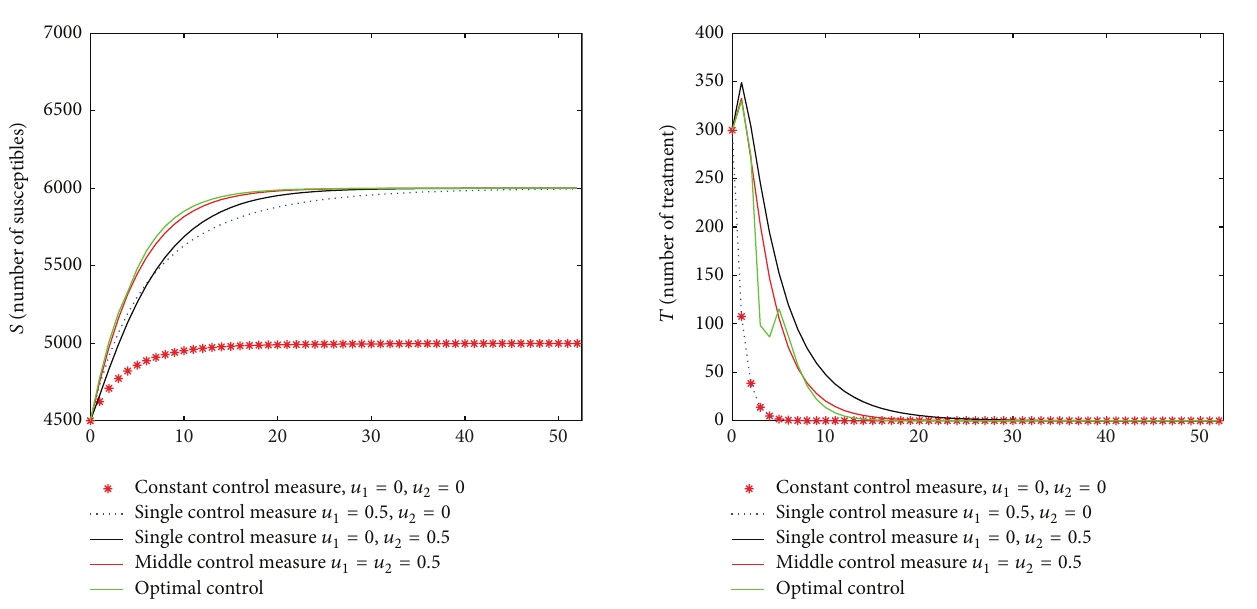
Figure5:Numberofthesusceptibleswhenwechoosetheweightsin objective function are 𝑐 1 = 10 2 ;𝑐 2 = 10 4 and under different optimal control strategies, that is, (1) without control: 𝑢 1 = 𝑢 2 = 0 ; (2) single control: 𝑢 1 = 0.5 , 𝑢 2 = 0 ; (3) single control: 𝑢 1 = 0 , 𝑢 2 = 0.5 ; (4) middle control: 𝑢 1 = 𝑢 2 = 0.5 ; (5) optimal control: 𝑢 1 = 𝑢 ∗ 1 , 𝑢 2 = 𝑢 ∗ 2 .